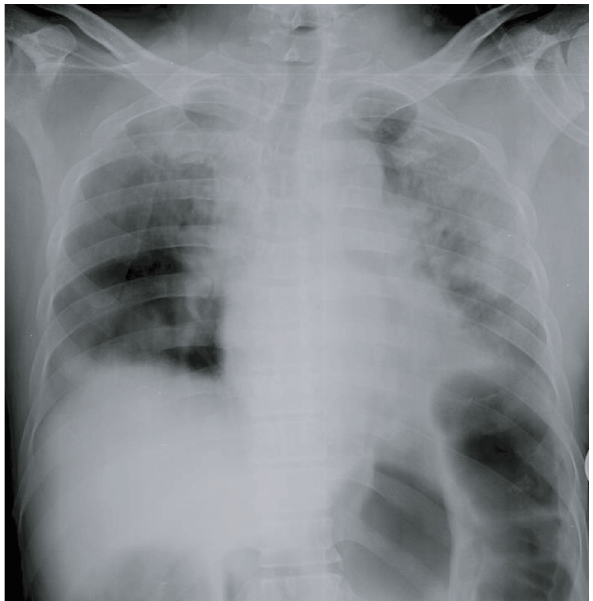
Figure 1: Chest radiograph of case 1 on the day of presentation with silent hypoxaemia showing extensive air space opaci fi cation involving both lungs with more changes on the left